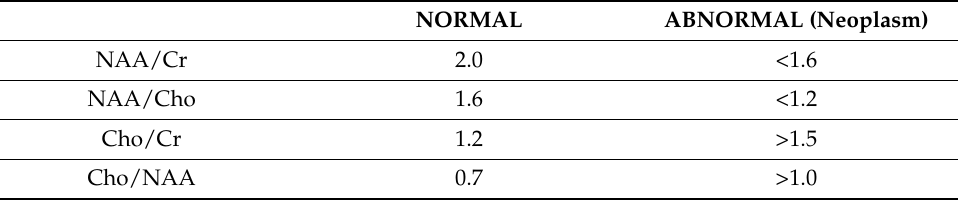
Table 4. Standard metabolic ratios